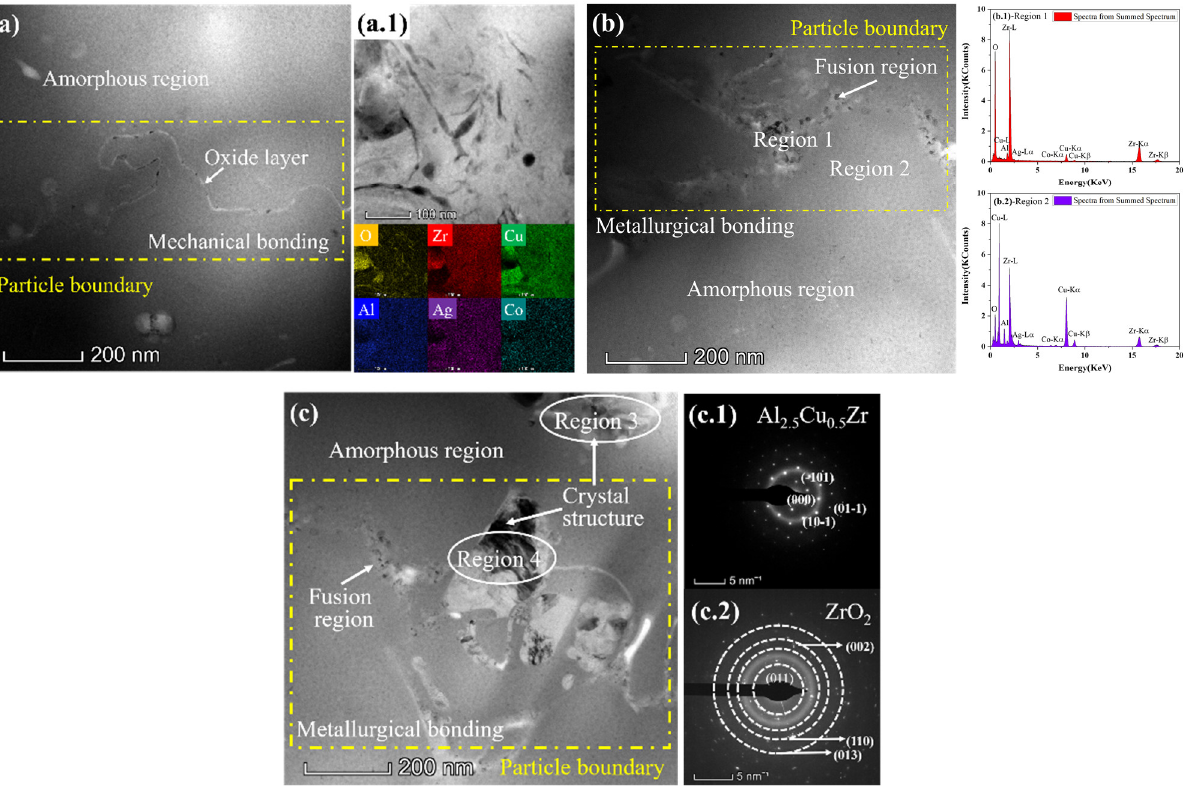
Figure 8. TEM and EDS results of the boundaries between two spraying particles. ( a ) S1, ( b ) S2, ( c ) S3. ( a.1 ) EDX mapping of S1. ( b.1 , b.2 ) EDS results of S2. ( c.1 , c.2 ) SAED patterns of S3.